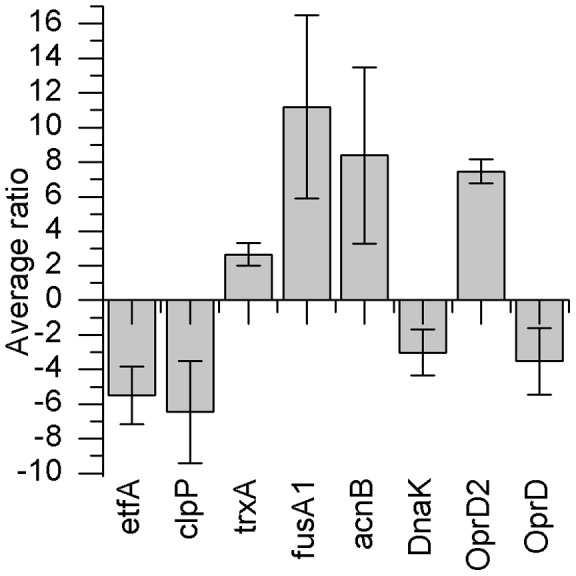
Average ratios of significantly different expressed proteins in comparative analysis of P. aeruginosa PAO1 treated with ZSB.2-D DIGE proteome analysis was performed of non-adapted ZSB treated and untreated P0 strains. The following proteins exhibiting significantly different abundance where identified: etfA: electron transfer flavoprotein subunit alpha; clpP: ATP-dependent Clp protease proteolytic subunit; trxA: thioredoxin; fusA1: elongation factor G; acnB: bifunctional aconitate hydratase 2/2-methylisocitrate dehydratase; DnaK: molecular chaperone DnaK; OprD2: OprD2-like porin precursor; OprD: Chain A, crystal structure of the outer membrane protein OprD. Average ratio indicates the standardised volume ratio between two protein spots in two experimental populations [54].